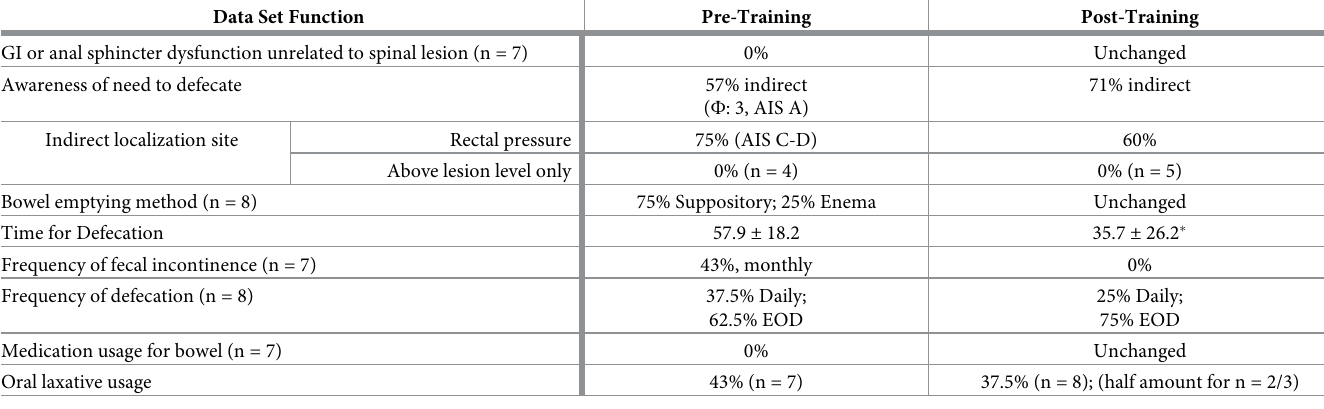
Table 3. Bowel items from international SCI data set [75,